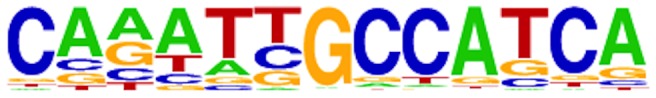
ChIP-Seq reveals the AmrZ consensus-binding site.Depiction of the consensus AmrZ binding site obtained by analyzing all AmrZ-enriched sequences. Consensus sequence contains an A/T rich region followed by GCC, followed by an A/T rich region. This sequence was observed in 54.7% of AmrZ-bound DNA, with a p-value of 1e-120. Motif analysis was performed utilizing tools within the HOMER analysis package.